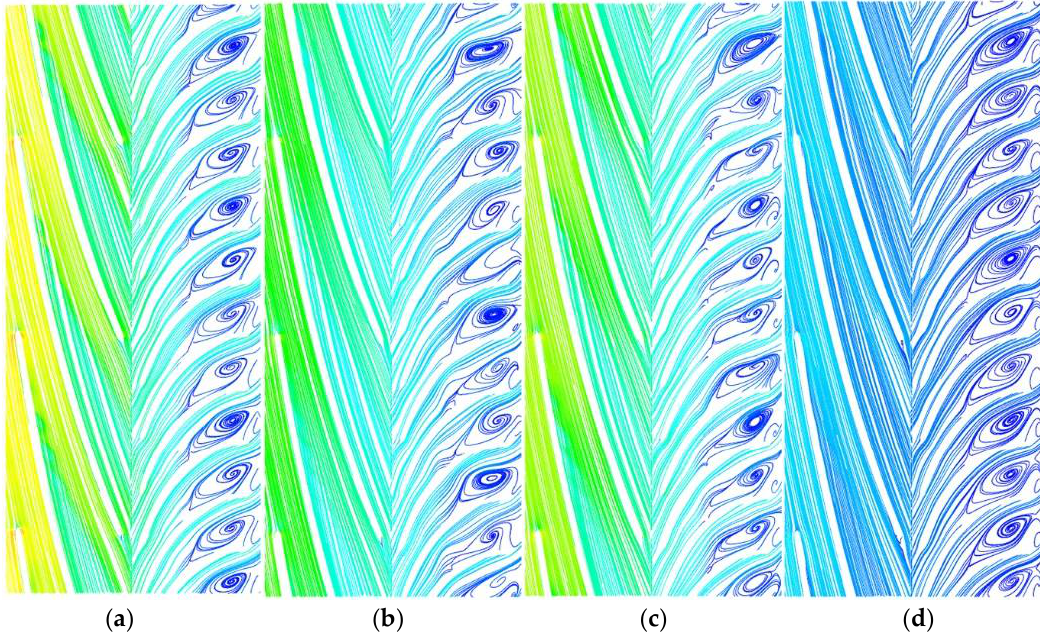
Figure 13. Streamline distribution in the impeller and diffuser under different GVFs. ( a ) GVF = 0%; ( b ) GVF = 5%; ( c ) GVF = 10%; ( d ) GVF = 15%.